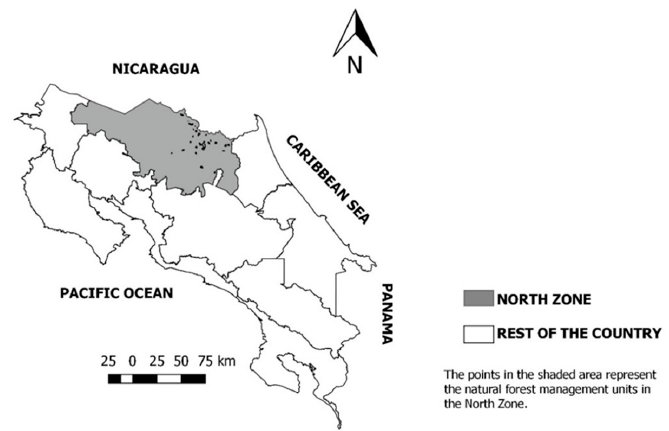
Figure 1. Location of the North Zone of Costa Rica corresponding to the study site.